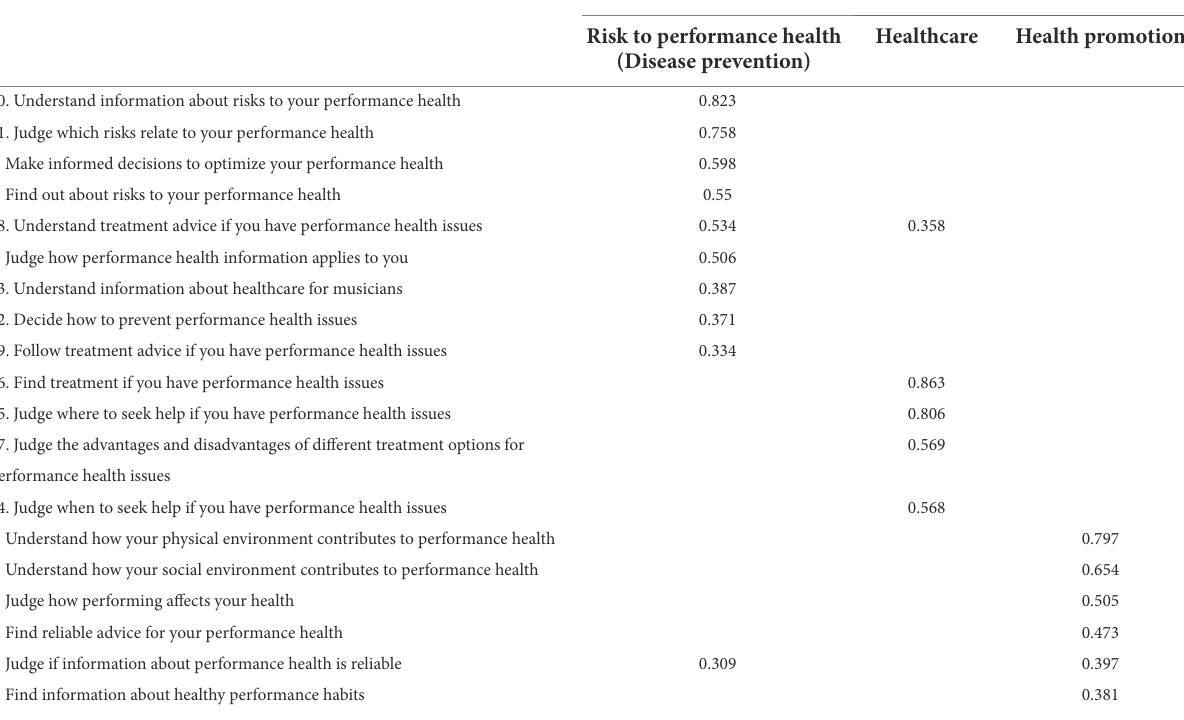
TABLE 3 Pattern matrix.